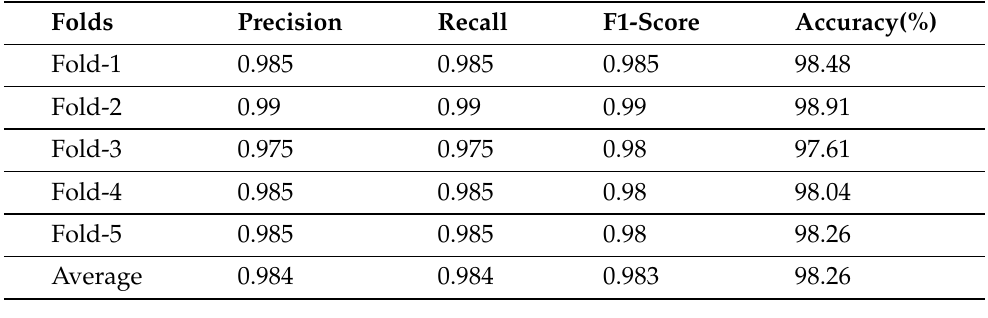
Table 10. Performance of the proposed model on each fold considering two-class COVID-19 vs. adult pneumonia.